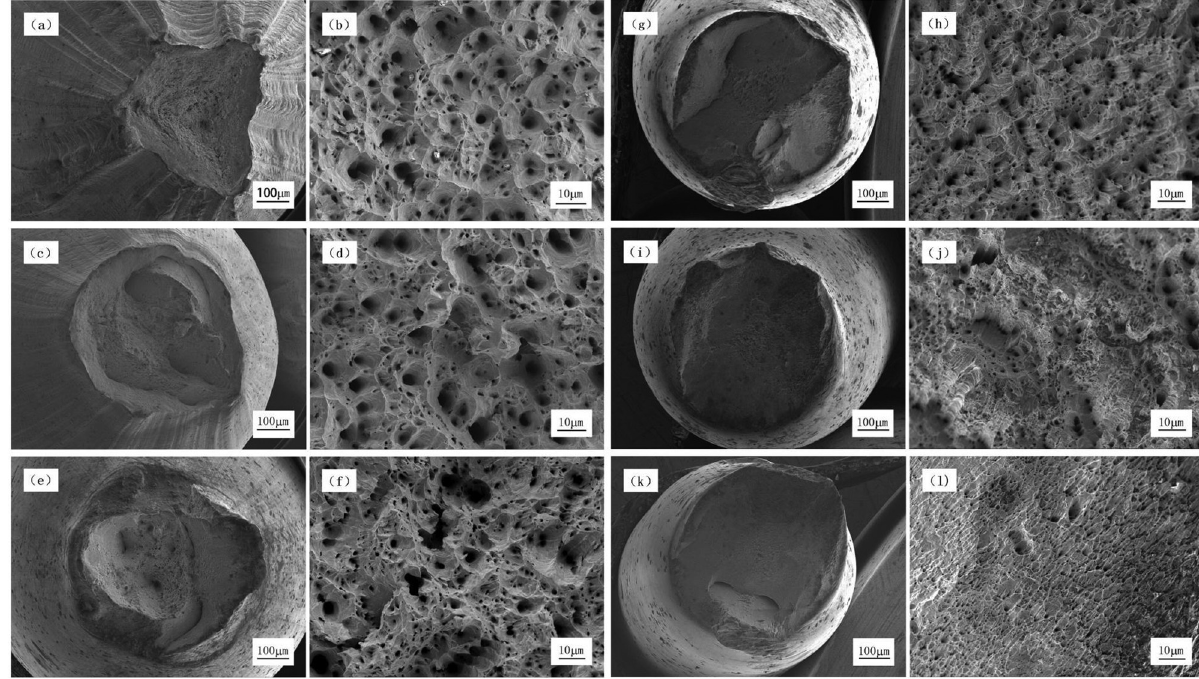
Figure 5: Fracture morphology of as - cast rod and as - drawn wire with di ff erent diameters ( a and b – 7.83 mm, η = 0; c and d – 5.34 mm, η = 0.77; e and f – 2.95 mm, η = 1.95; g and h – 2.13 mm, η = 2.6; k and l – 1.49 mm, η = 3.31 )